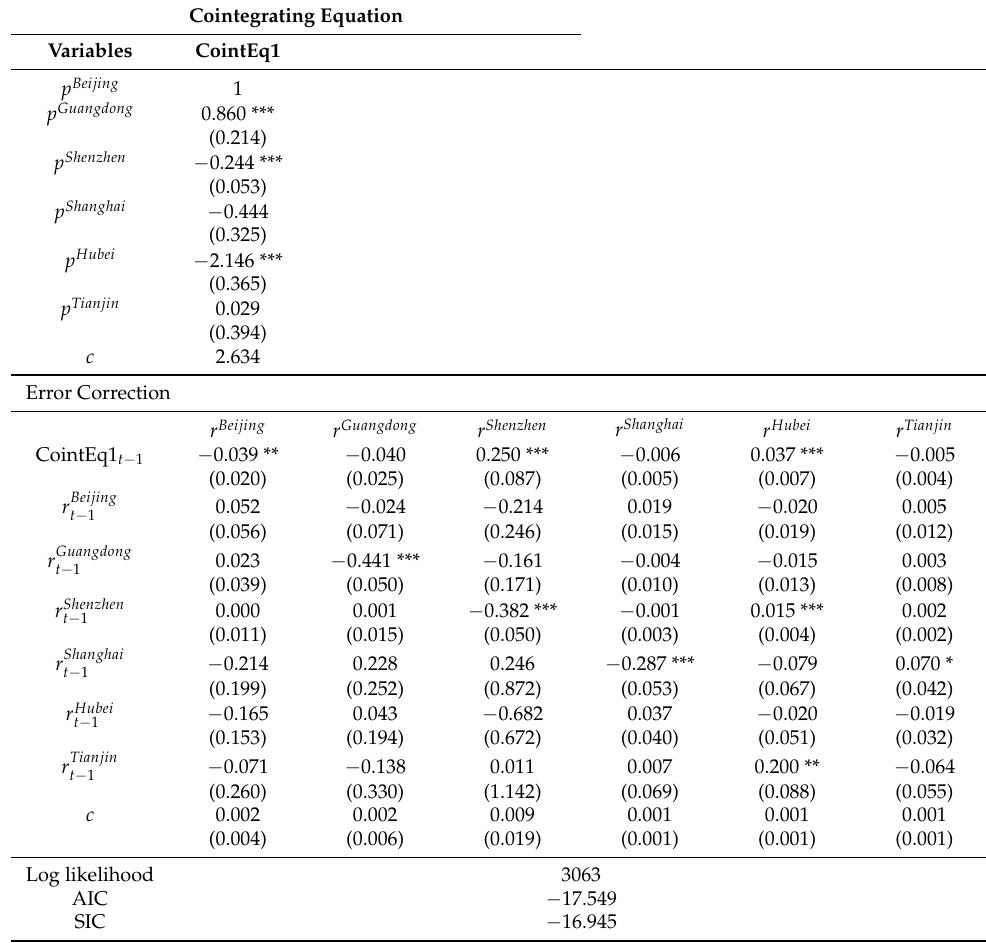
Table 6. VECM estimation result for the second